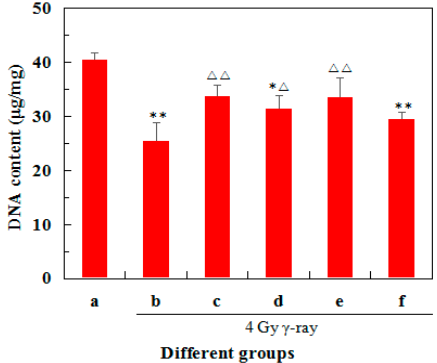
Figure 2. Effects of 5 ′ -AMP on splenic DNA content in mice treated with γ -ray (mean ± SD, n = 6). (a) Group I: Normal group; (b) Group II: Model group; (c) Group III: Positive control (berberine hydrochloride); (d) Group IV: Radiation + 5 ′ -AMP (0.08 g/kgBW/day); (e) Group V: Radiation + 5 ′ -